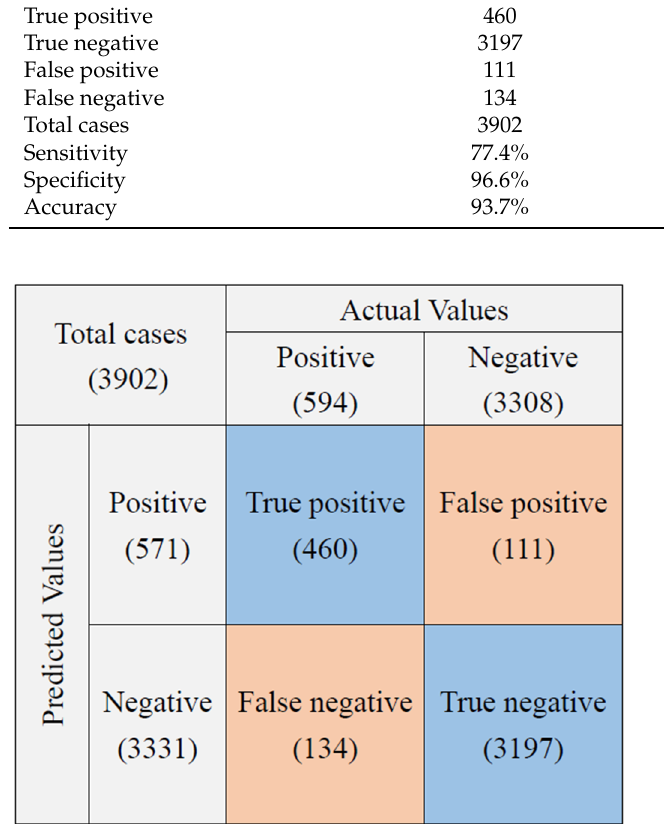
Figure 5. The confusion matrix of automation system with 200 images capture setting. Table 4. The performance of the automated TB smear microscopy system and manual microscopy after removal of inadequate